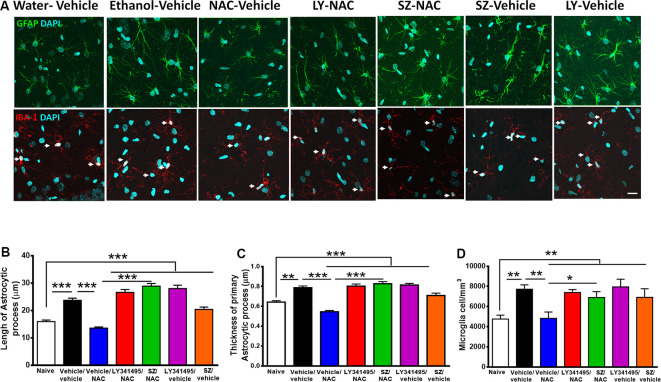
Alcohol-induced neuroinflammation is inhibited by N-acetylcysteine (NAC; 100 mg/kg per day): effect blocked by inhibitors of xCT-transporter and mGlu2/3 receptor. (A, Top) Astrocyte immunofluorescence (GFAP immunoreactivity, green; DAPI, blue; A, bottom: microglia immunofluorescence (IBA-1 immunoreactivity, red; DAPI, blue, depicted by white arrows). Scale Bar 25 μm. Rats ingested alcohol chronically for 48 days followed by 14 days of ethanol deprivation and further 2 days of ethanol reaccess. Alcohol-treated rats treated with vehicle (vehicle/vehicle group) led to an increase in length (analysis of variance: F6, 1531 = 55.61, ***P < 0.001; Tukey post hoc: naive compared to vehicle/vehicle-treated group ***P < 0.001) and thickness (F6, 733 = 35.77, ***P < 0.001; Tukey post hoc: naive compared to vehicle/vehicle-treated group **P < 0.01) of astrocyte processes (B,C) and to an increase in microglial density (F6, 44 = 4.543; **P < 0.01; Tukey post hoc: naive compared to vehicle/vehicle-treated group *P < 0.05; D) compared to (naive) rats drinking water. The administration of NAC (vehicle/NAC) fully normalized the ethanol-induced increase in astrocyte length (Tukey post hoc: vehicle/vehicle-treated compared to vehicle/NAC-treated group ***P < 0.001) and thickness (post hoc: vehicle/vehicle-treated compared to vehicle/NAC-treated group ***P < 0.001). N-acetylcysteine also blocked the ethanol-induced increase in microglial density (D; Tukey post hoc: vehicle/vehicle-treated compared to vehicle/NAC-treated group *P < 0.05). Pretreatment prior to ethanol reaccess with LY341495, an antagonist of glutamate mGlu2/3 receptors and SZ, an inhibitor of xCT-cystine/glutamate exchanger, prevented the NAC-induced normalization of length (vehicle/NAC-treated compared to LY341495Y/NAC-treated group ***P < 0.001 and vs. SZ/NAC-treated group ***P < 0.001) and thickness (vehicle/NAC-treated compared to LY341495Y/NAC-treated group ***P < 0.001; and compared to SZ/NAC-treated group ***P < 0.001) of astrocytic process. Pretreatment with LY341495 or sulfasalazine also blocked the effect of NAC on microglial density (vehicle/NAC-treated compared to LY341495Y/NAC-treated treated group *P < 0.05, and compared to SZ/NAC-treated group *P < 0.05). Data are presented as mean ± SEM, n = 6 rats per experimental group.